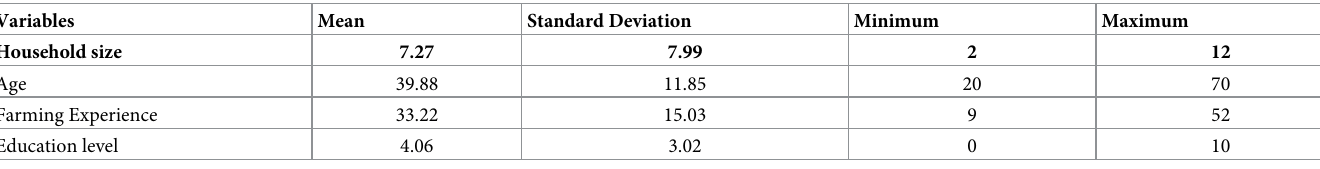
Table 2. Demographic characteristics of sample